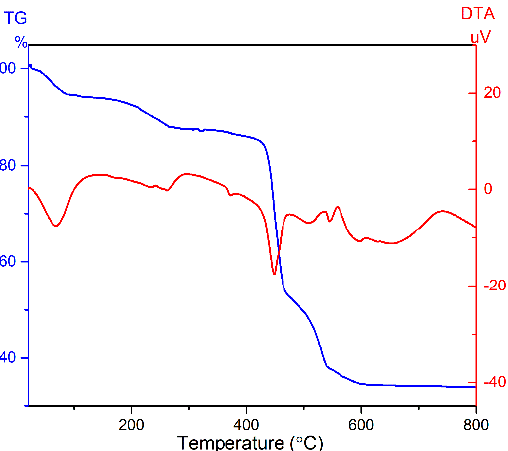
Figure 2. TG (blue) and DTA (red) curves of the [N(CH 3 ) 4 ] 2 ZrF 6 :1%Mn 4+ sample recorded under N 2 atmosphere.